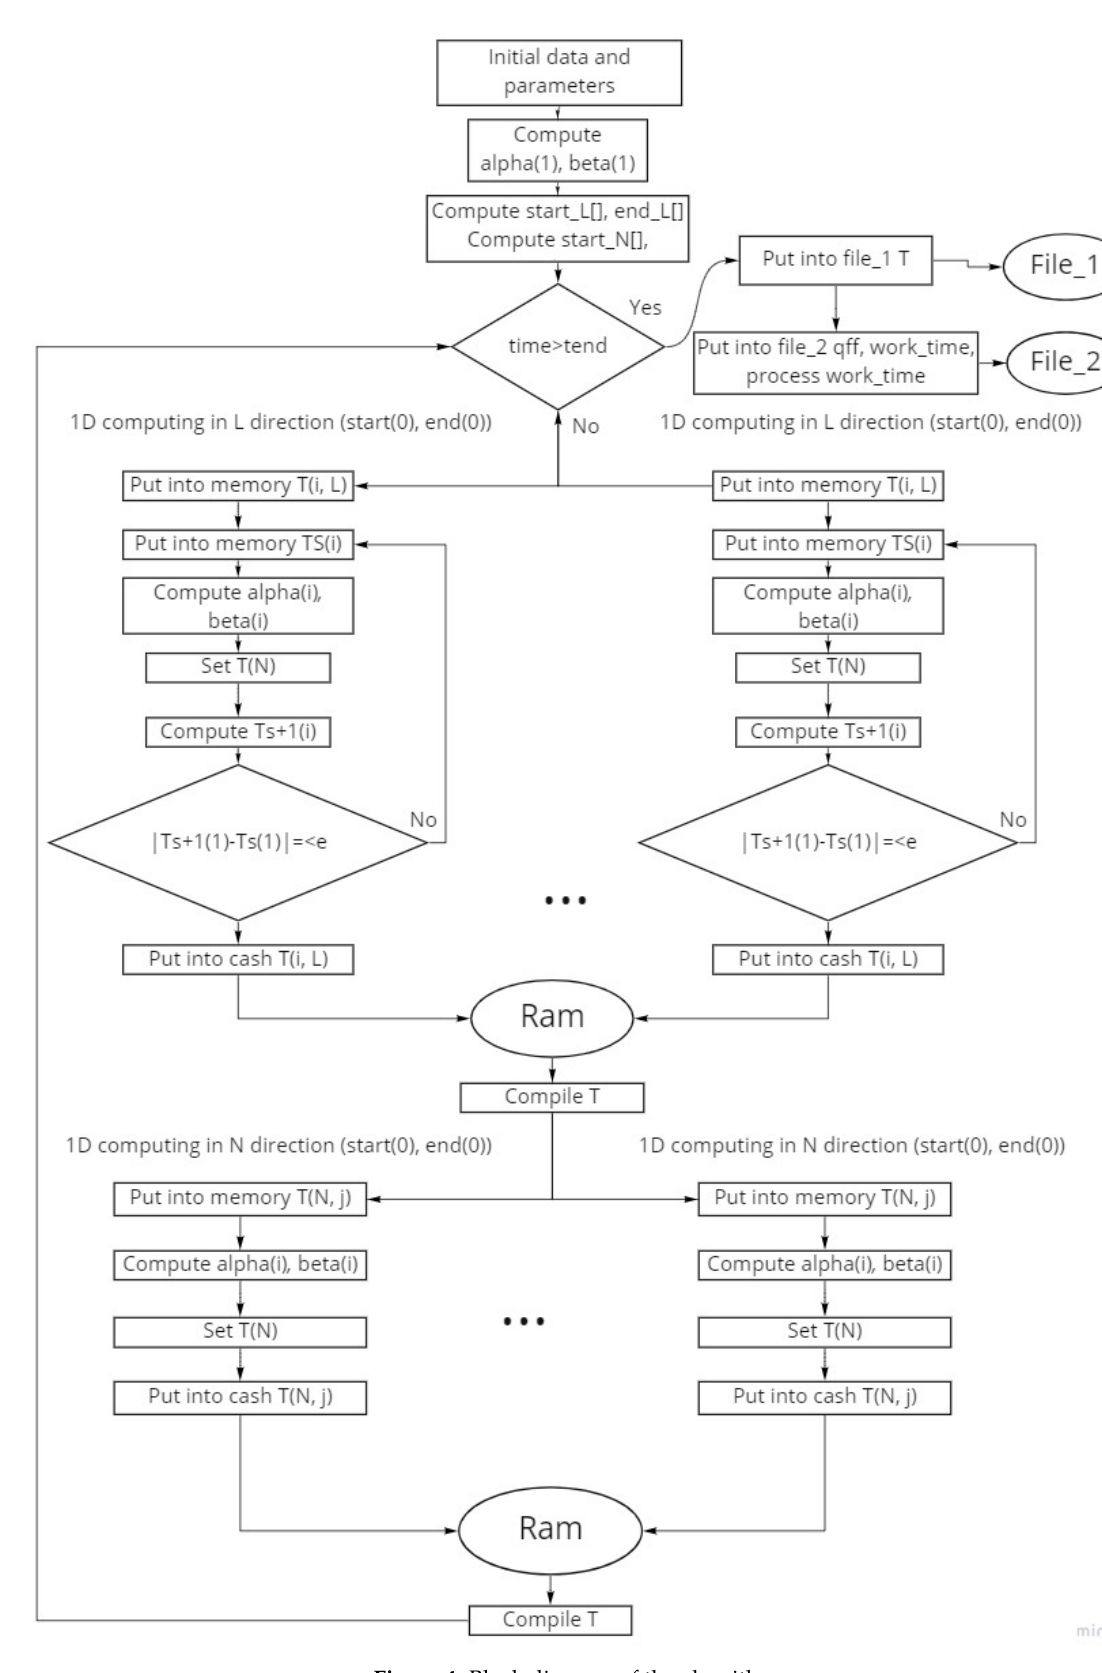
Figure 4. Block diagram of the algorithm.